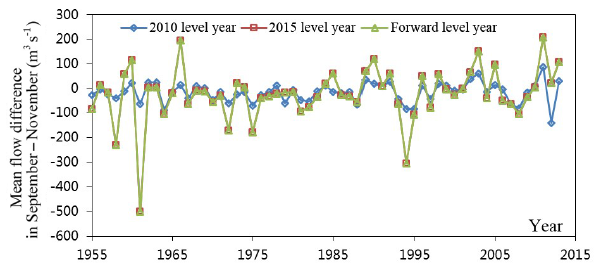
Figure 9. Process of mean flow of Xiangjiaba Hydrological Station from September to November in different level years and the natural condition.